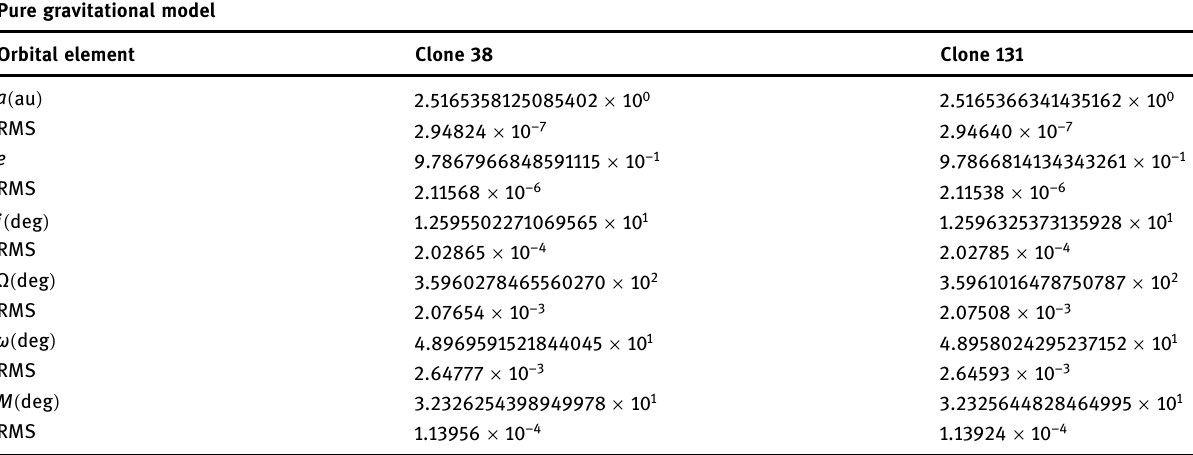
Table 4: Border clones of the LOV of initial nominal keplerian orbital elements of comet 322P together with their uncertainties ( RMS )